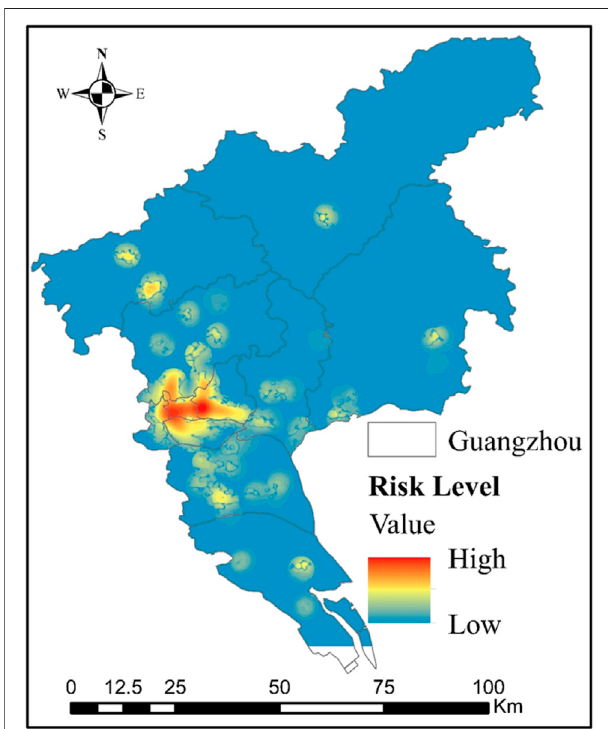
FIGURE 8 | Distribution map of the risk level of COVID-19 in February 2021 (the forecast of COVID-19 risk level in February 2021 is shown in the fi gure, in which the color ranges from black to white, indicating the predicted value of COVID-19 risk level ranging from low to high).